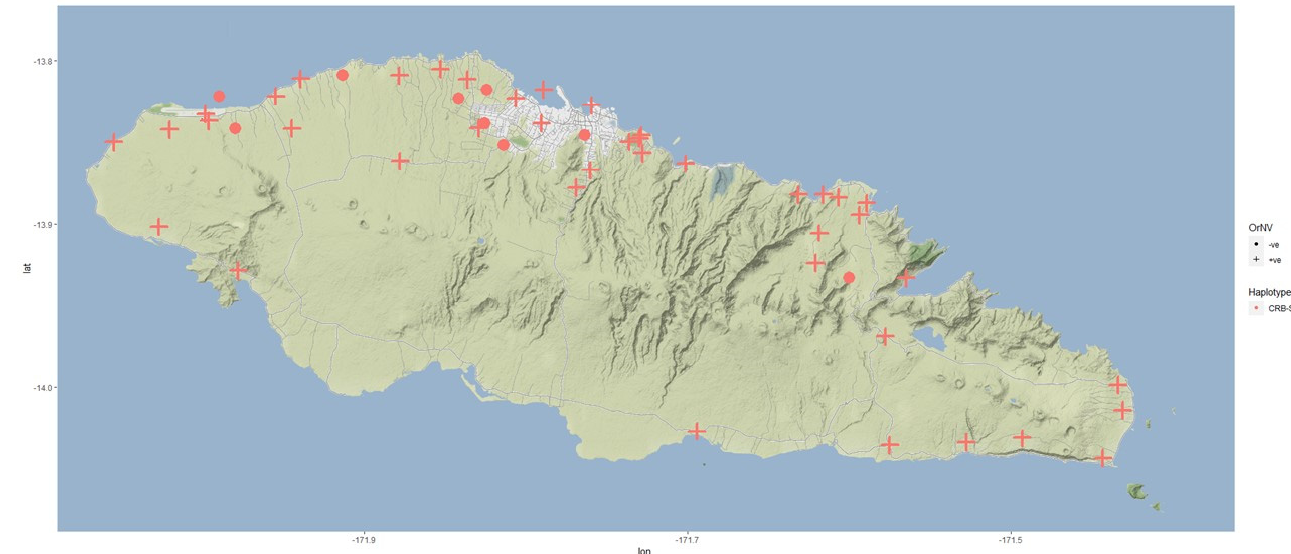
Figure 6. Determination of haplotype grouping as well as presence or absence of OrNV on CRB ( Oryctes rhinoceros ) samples collected from pheromone trap network in Upolu, Samoa. Red crosses indicate the traps from which the CRB samples were OrNV positive whereas red dots indicate traps with OrNV negative CRB samples. Longitude values are shown on the x-axis and the latitude values on the y-axis.